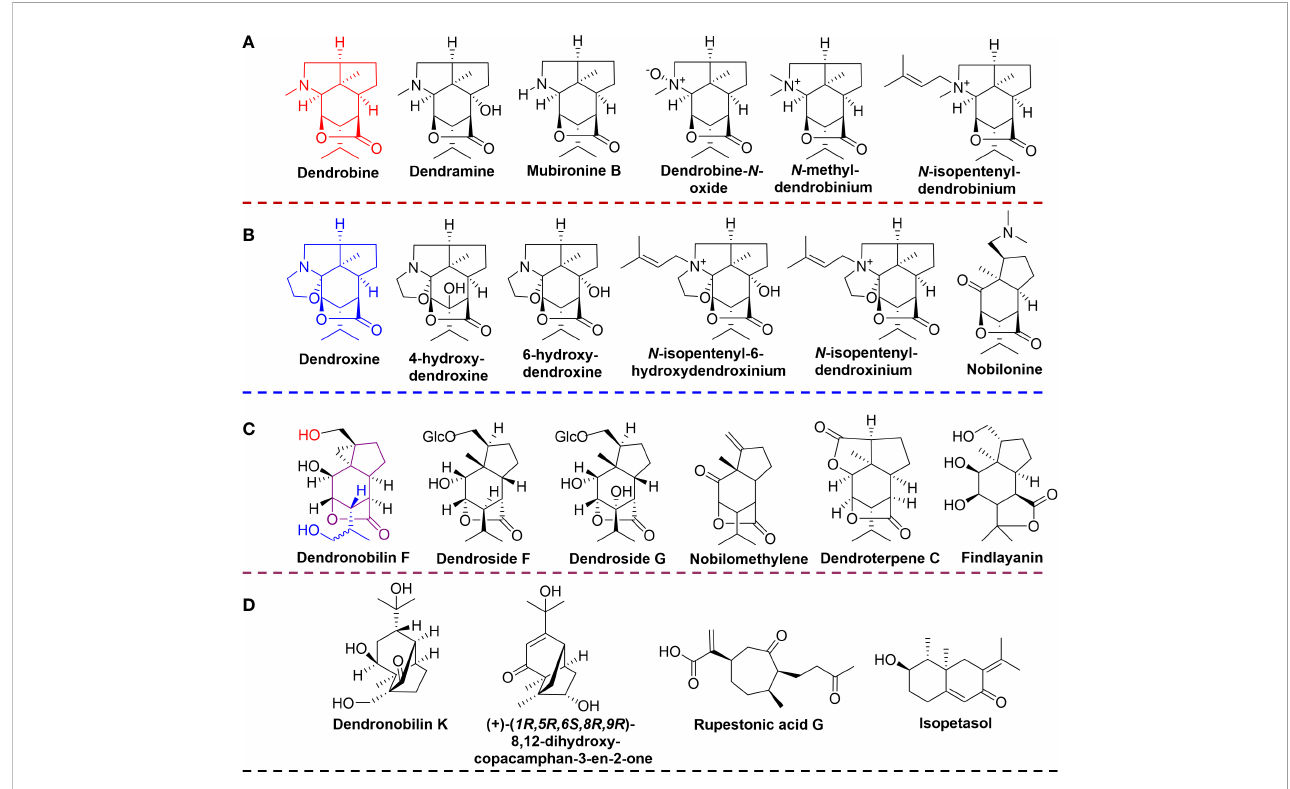
FIGURE 1 The structures of identi fi ed alkaloids and sesquiterpenes. (A) dendrobine-type alkaloids; (B) dendroxine-type alkaloids; (C) dendrobine-type sesquiterpenes; (D) other type